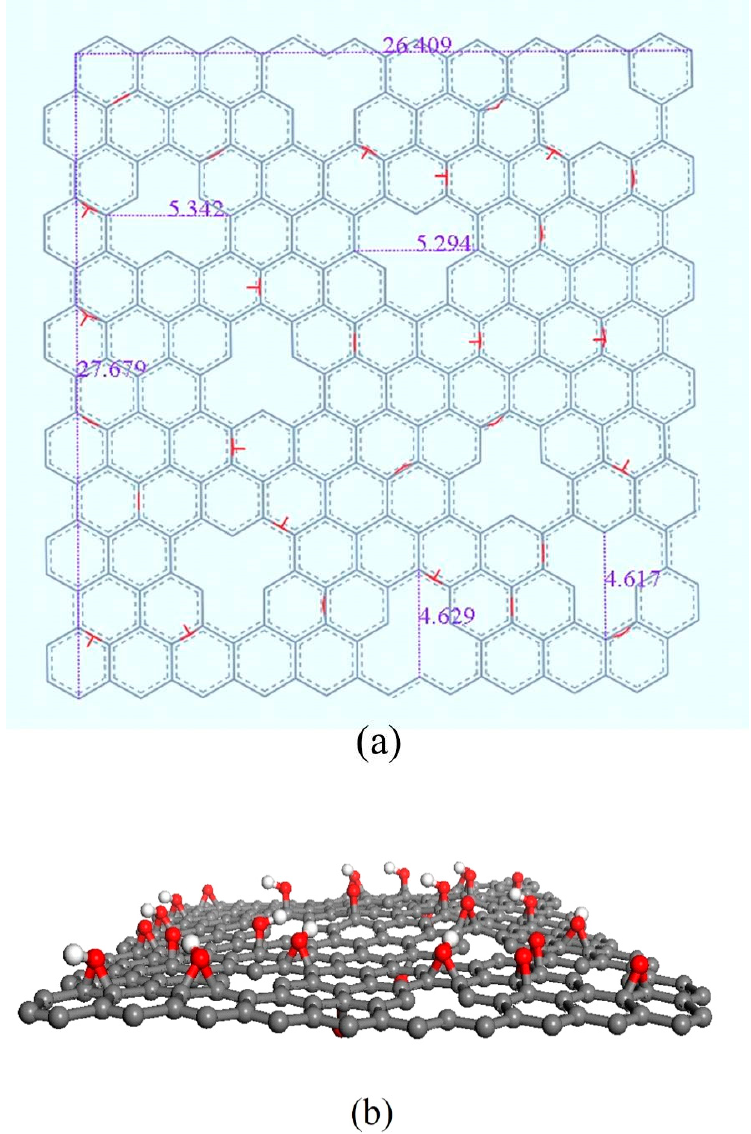
Figure 1. ( a ) Dimensions (in Å) of the constructed holey graphene (HGNS). ( b ) Tilted view of HGNS revealing the epoxy and hydroxyl groups. The red and white colors are for O and H atoms, respectively.